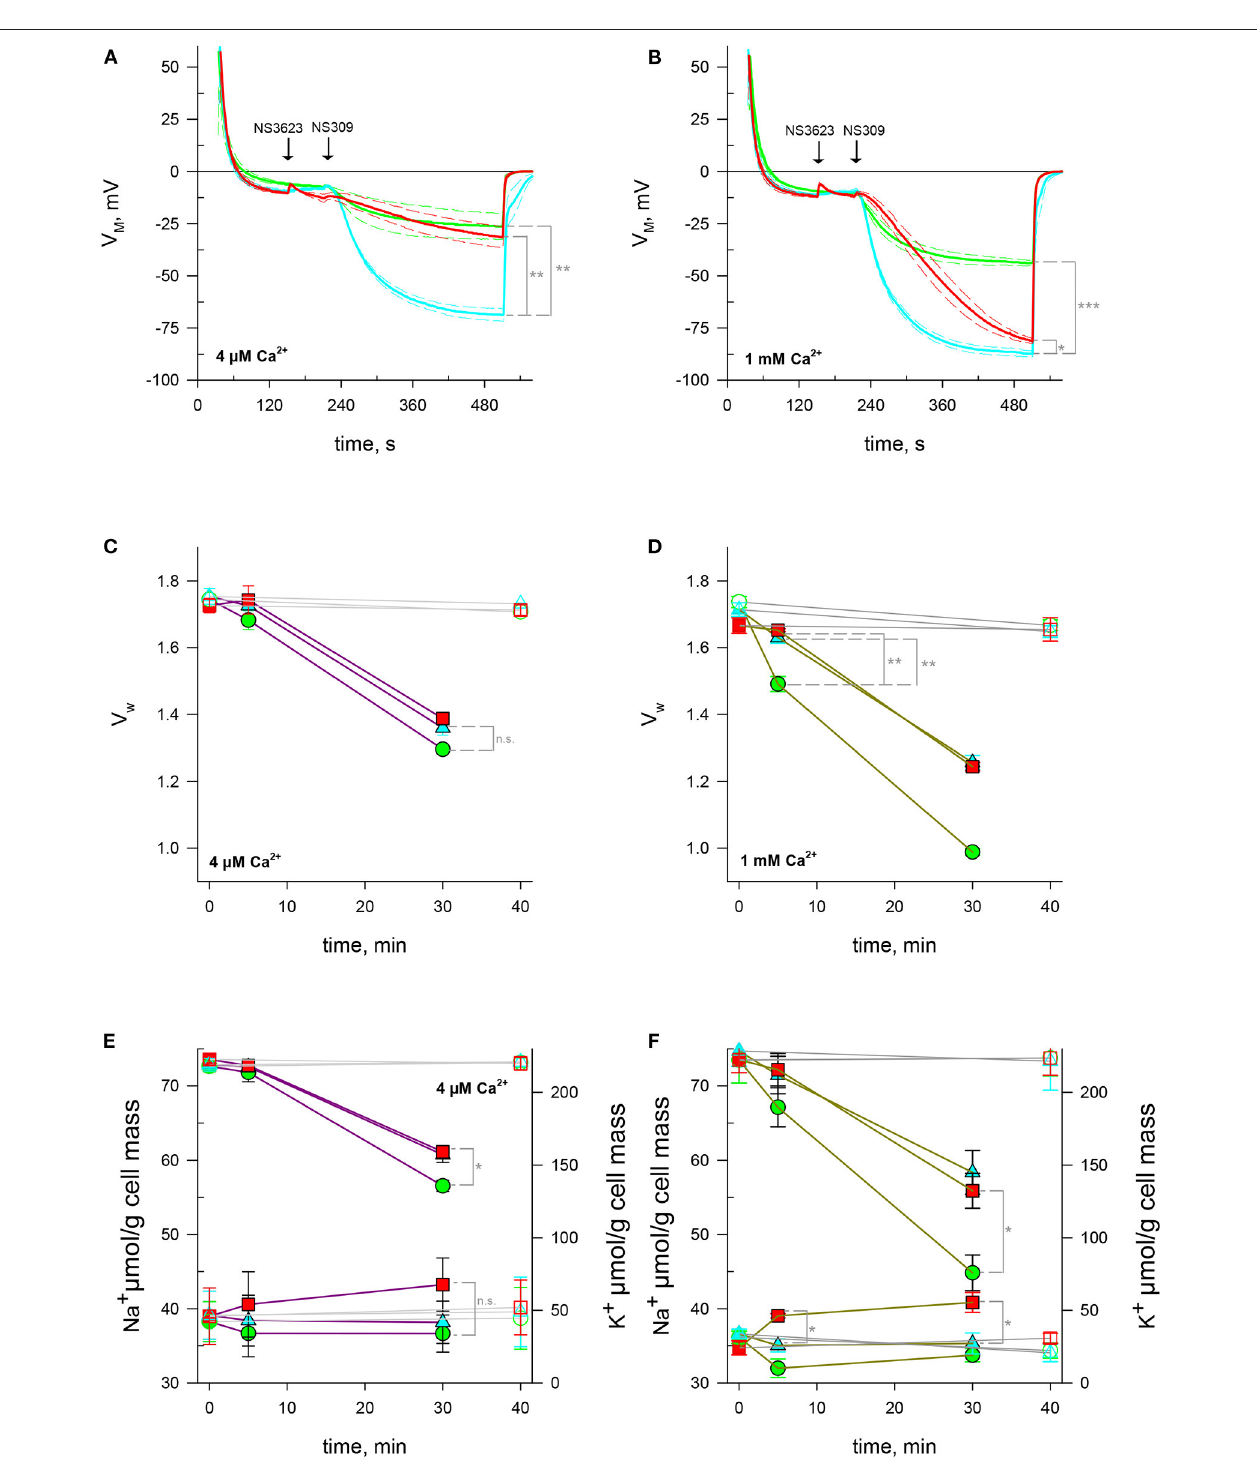
FIGURE 3 | NSC activity enhanced by high concentrations of NS3623 in hyperpolarizing conditions is driving force dependent. (A, B) Evolution of membrane potential from cells injected into normal Ringer solutions containing 4 µ M (A) or 1mM (B) extracellular CaCl 2 , treated with 0 µ M (green), 10 µ M (cyan) or 100 µ M (red) of NS3623 and hyperpolarized with NS309 (100 µ M). Average of n = 3 experiments, dashed lines indicate ± SEM. (C–F) Intracellular water content (wet weight/dry weight), (C, D) and quantity of Na + (bottom traces) and K + (top traces), (E, F) of red cells treated with 0 (green), 10 (cyan) or 100 µ M (red) of NS3623 and with (closed symbols, colored lines) or without (open symbols, gray lines) 100 µ M NS309, in the presence of 4 µ M (C, E) or 1mM (D, F) of extracellular CaCl 2 . Bars denote SEM, average of five (C, E) or three (D, F) independent experiments. n.s., not significant, * p < 0.05, ** p < 0.01; *** p < 0.001.